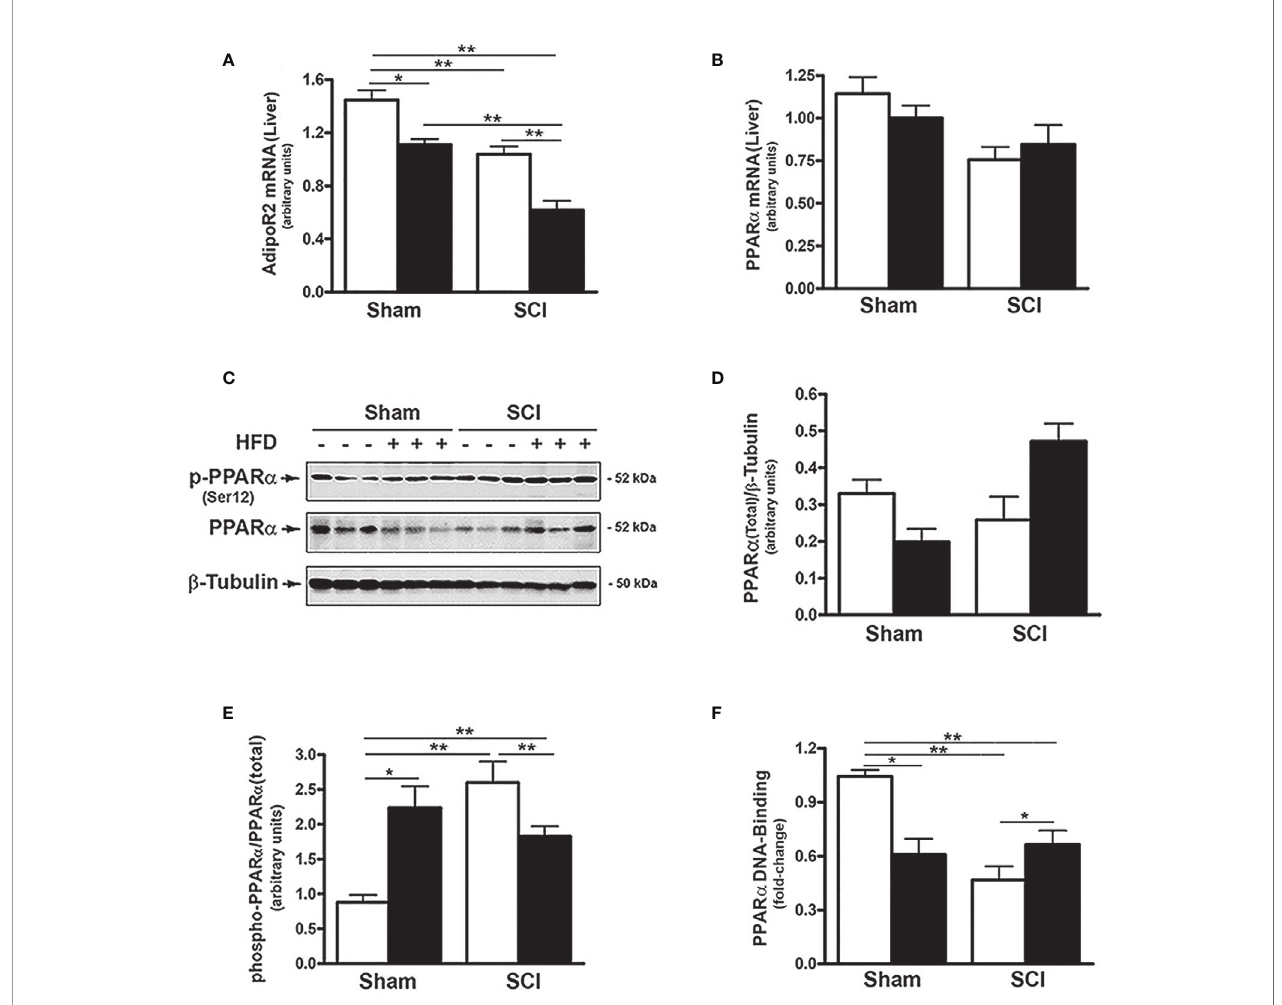
FIGURE 3 | SCI suppressed AdipoR2 expression and PPAR a activation - Mice were fed with either ConD (White Bar) or HFD (Black Bar) after surgery. Total RNA was isolated from mouse liver and subjected to Rt-PCR analysis for (A) , AdipoR2 mRNA; (B) , PPAR a mRNA. (C) , total protein lysates were extracted from mouse liver and subjected to Western blot analysis using anti-endogenous PPAR a , or anti-phospho-PPAR a (Ser12), or b -tubulin antibodies; (D) , blots were quanti fi ed by scanning densitometry and blots in the middle panel of (C) were normalized relative to b -tubulin (lower panel); (E) , blots in the upper panel of (C) were normalized relative to endogenous (total) PPAR a protein (middle panel). (F) , Nuclear extracts were prepared from mouse liver and subjected to PPAR a DNA-binding assay. Data shown are means values ± SEM (n = 5). Data shown in C are representative Western blots; * p < 0.05; ** p <